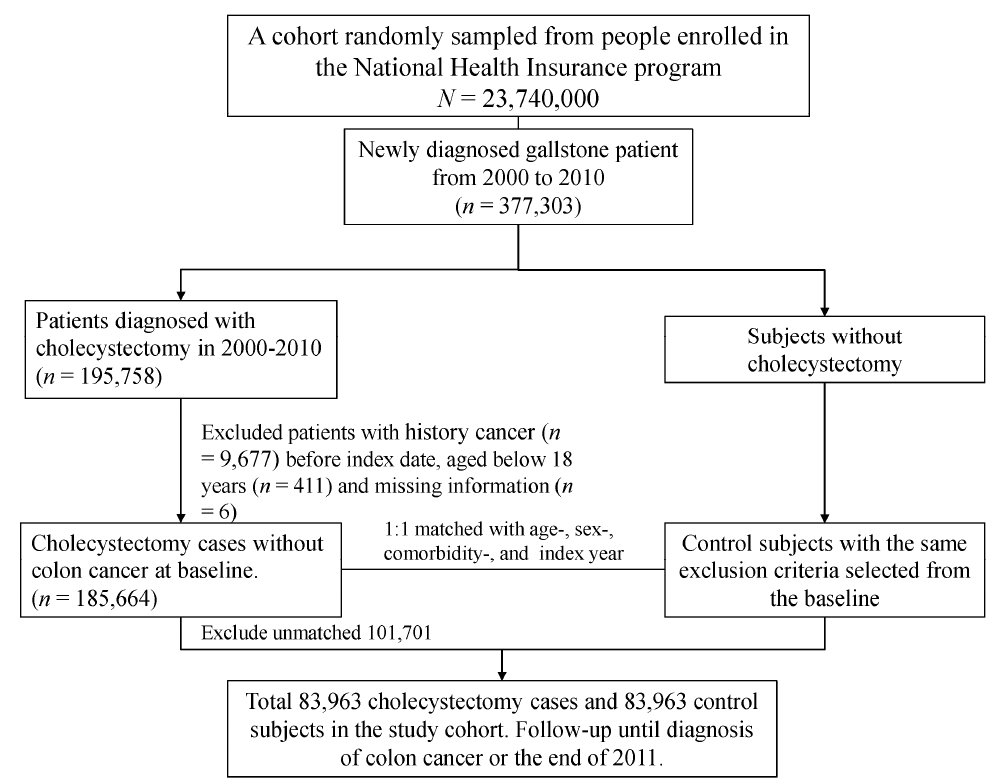
Figure 1. The selection process for the gallbladder stones patients with and without cholecystectomy in the 2 study cohorts. in the 2 study